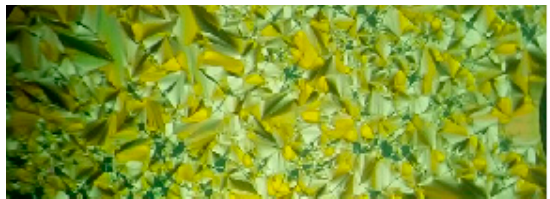
Figure 2. Polarized optical microscopy (POM) texture of SmA phase upon cooling of compound I 8 at 80.0 °C, as an example.